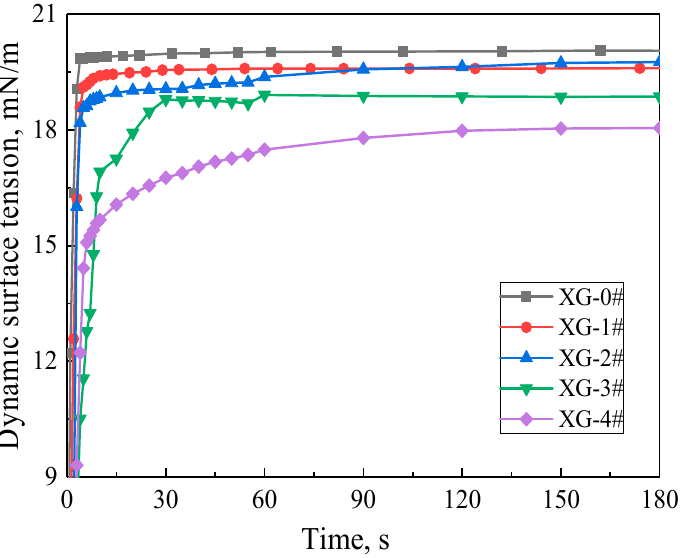
Figure 1. Dynamic surface tension of the foam dispersions. The EST, conductivity and dynamic viscosity of the foam dispersion are shown in Table 2. For the SDS/FS-50 dispersion containing NP without XG, the surface tension and conductivity decreased slightly, and the viscosity increased slightly. Adding 0.01% XG to the dispersion of SDS/FS-50/NPs resulted in a slight increase in conductivity, but the conductivity gradually decreased with the increase in the XG concentration. The dynamic viscosity of the SDS/FS-50/NPs mixture increased sharply with the increase in XG concentration. In particular, at the concentration of 5% NPs and 0.05% XG, the dynamic viscosity of foam dispersions reached 870.58 mPa·s, implying that the molecular interactions among surfactants, XG, and NPs resulted in a synergistic thickening effect. The main reason is that the relative molecular of XG mass exceeds a million, and it is known to be highly entangled in solution. The macromolecular dimensions and molecular weight of XG increased effectively because of the intermolecular interaction or intense entanglement of the XG molecules in solution. The effectively increased macromolecular dimensions and molecular weight improved the viscosity of the mixed solutions. Table 2. Basic properties of foam dispersions.